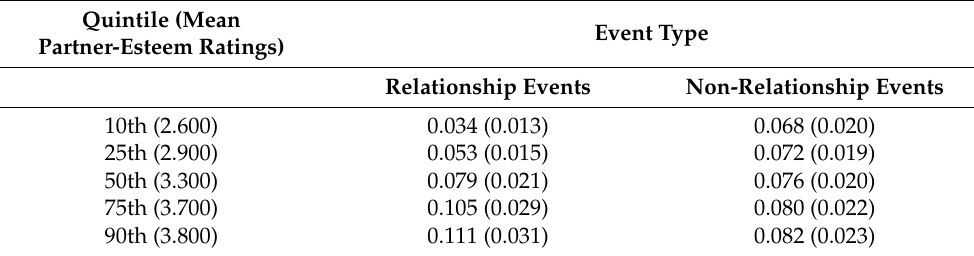
Table 5. Conditional Indirect Effects of Fading Affect Bias (FAB) for Relationship and Non- Relationship Events across Quintiles of Self-Reported Partner-Esteem Ratings through Event Re- hearsal Frequency Ratings.